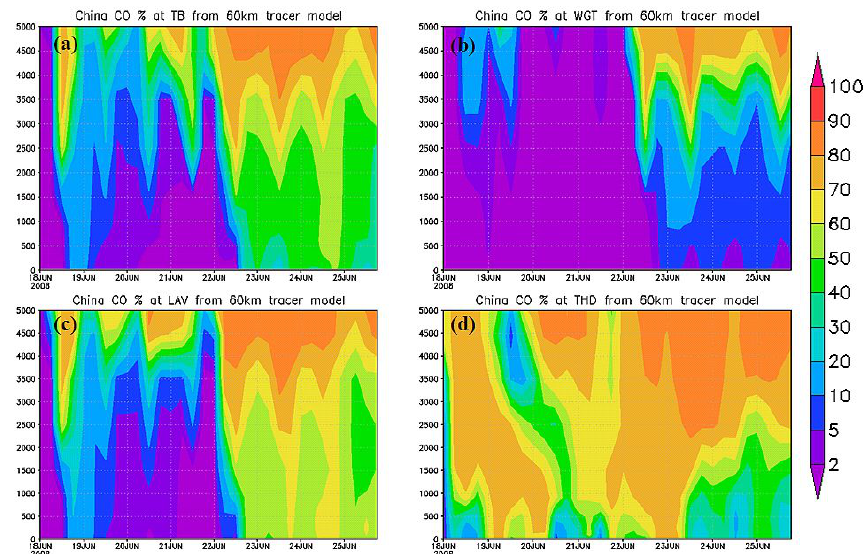
Fig. 6. Time-height (a.g.l., m) curtain plots of anthropogenic China CO contributions as % across sites at (a) TB (b) WGT (c) LAV and (d) THD. Their elevations are 572m, 0m, 1756m and 20m,